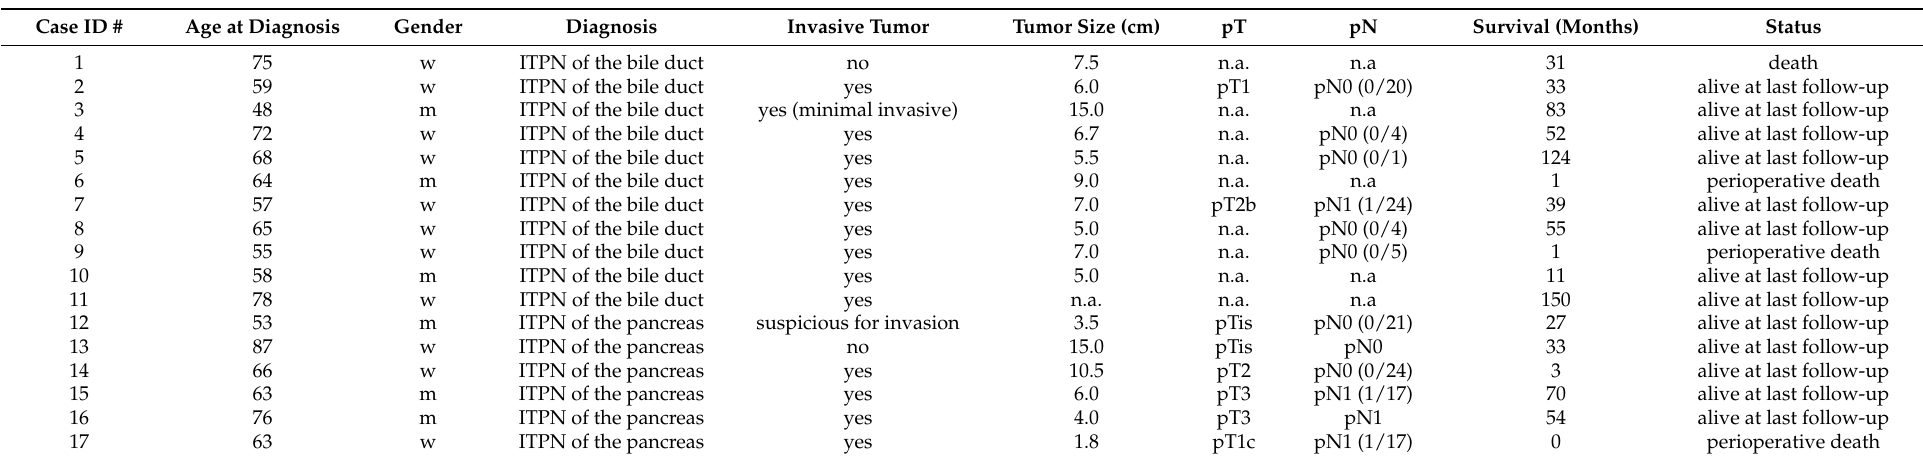
Table A1. Detailed clinical, pathological, and follow-up data of ITPN